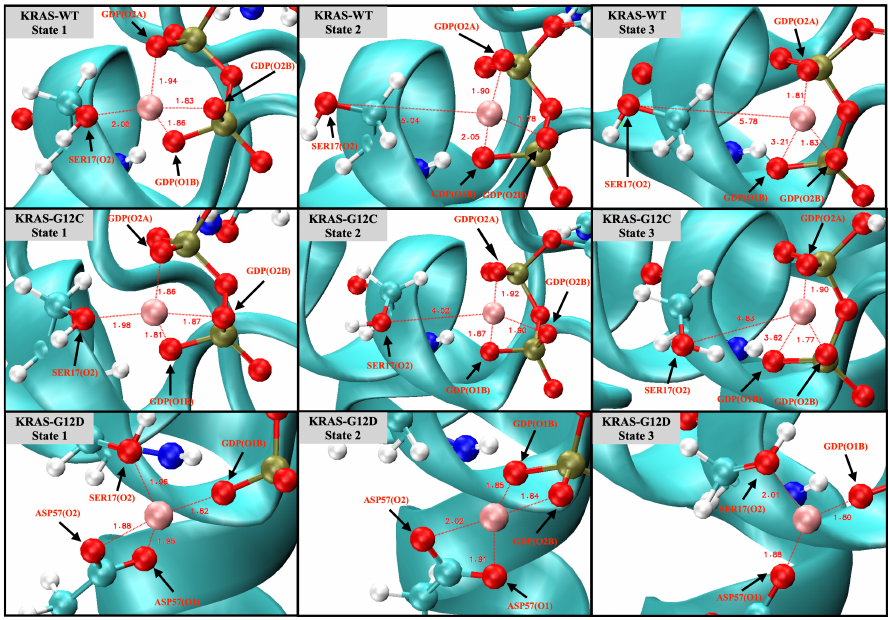
Figure 1. Snapshots of the coordination bonds between Mg 2 + and SER17, ASP57 and GDP. Water molecules are hidden for the sake of